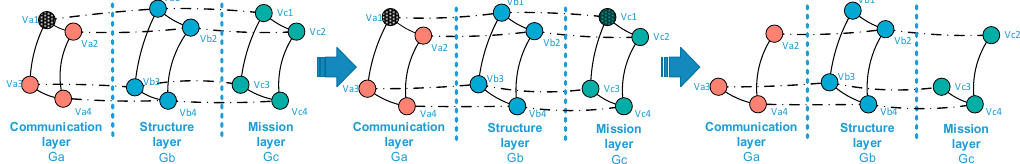
Figure 4. Interlayer relationships between the structure layer and mission layer.